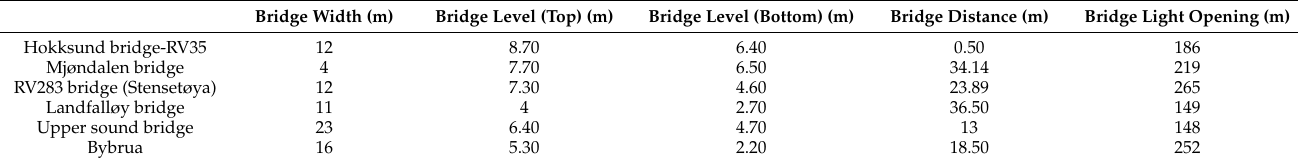
Table 1. Properties of the bridges.